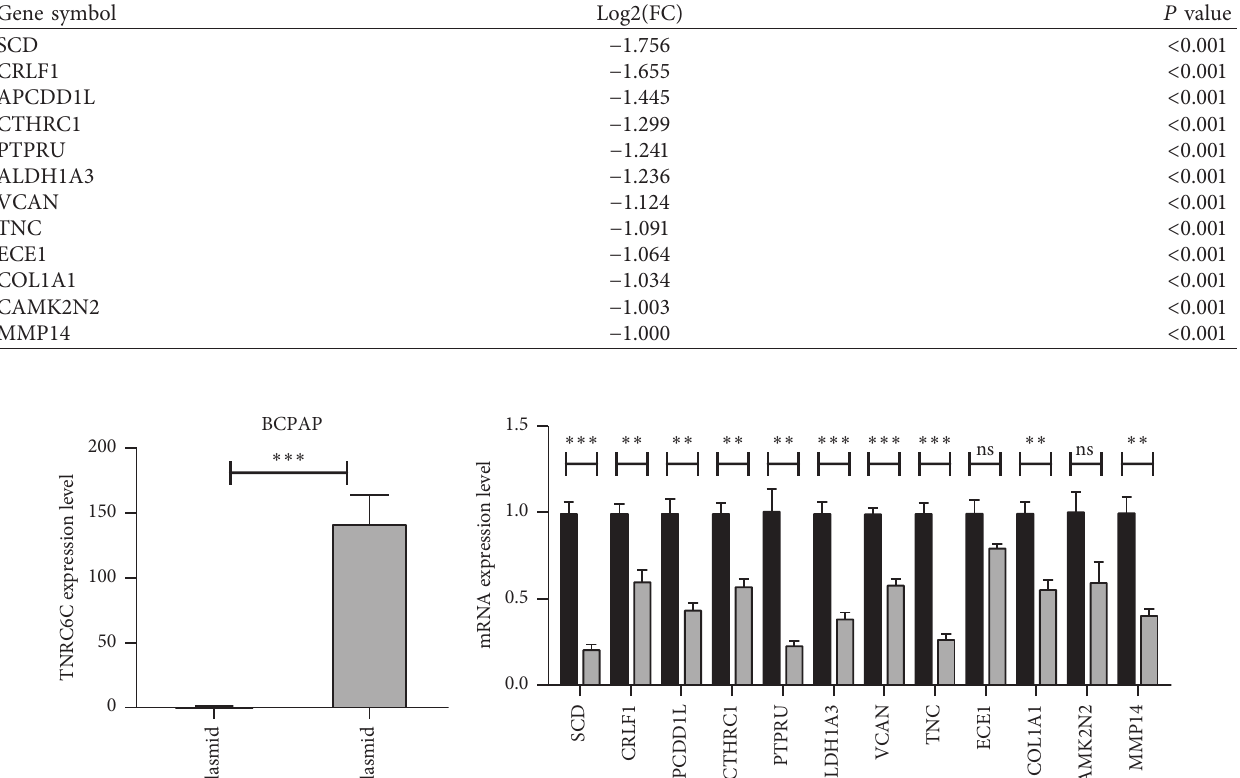
Table 3: Significant fold changes of 12 potential target genes expression between TNRC6C overexpressed BCPAP cells and control cells.